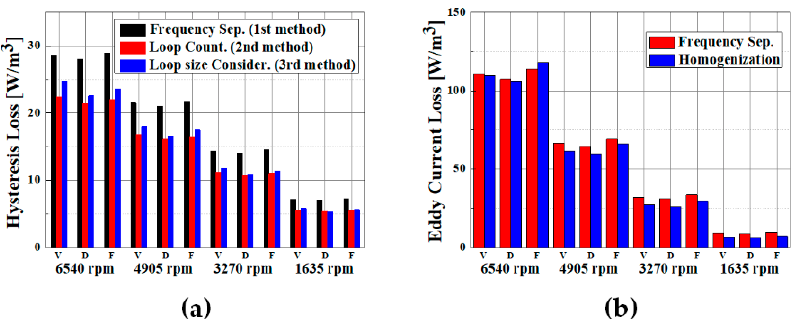
Figure 9. ( a ) Three different hysteresis loss calculation with 4 steps different operation points. ( b ) Two different eddy current loss calculation with 4 steps different operation points. Table 1. Comparison of iron losses of three different calculation methods at 6540 rpm, 24 A phase current.